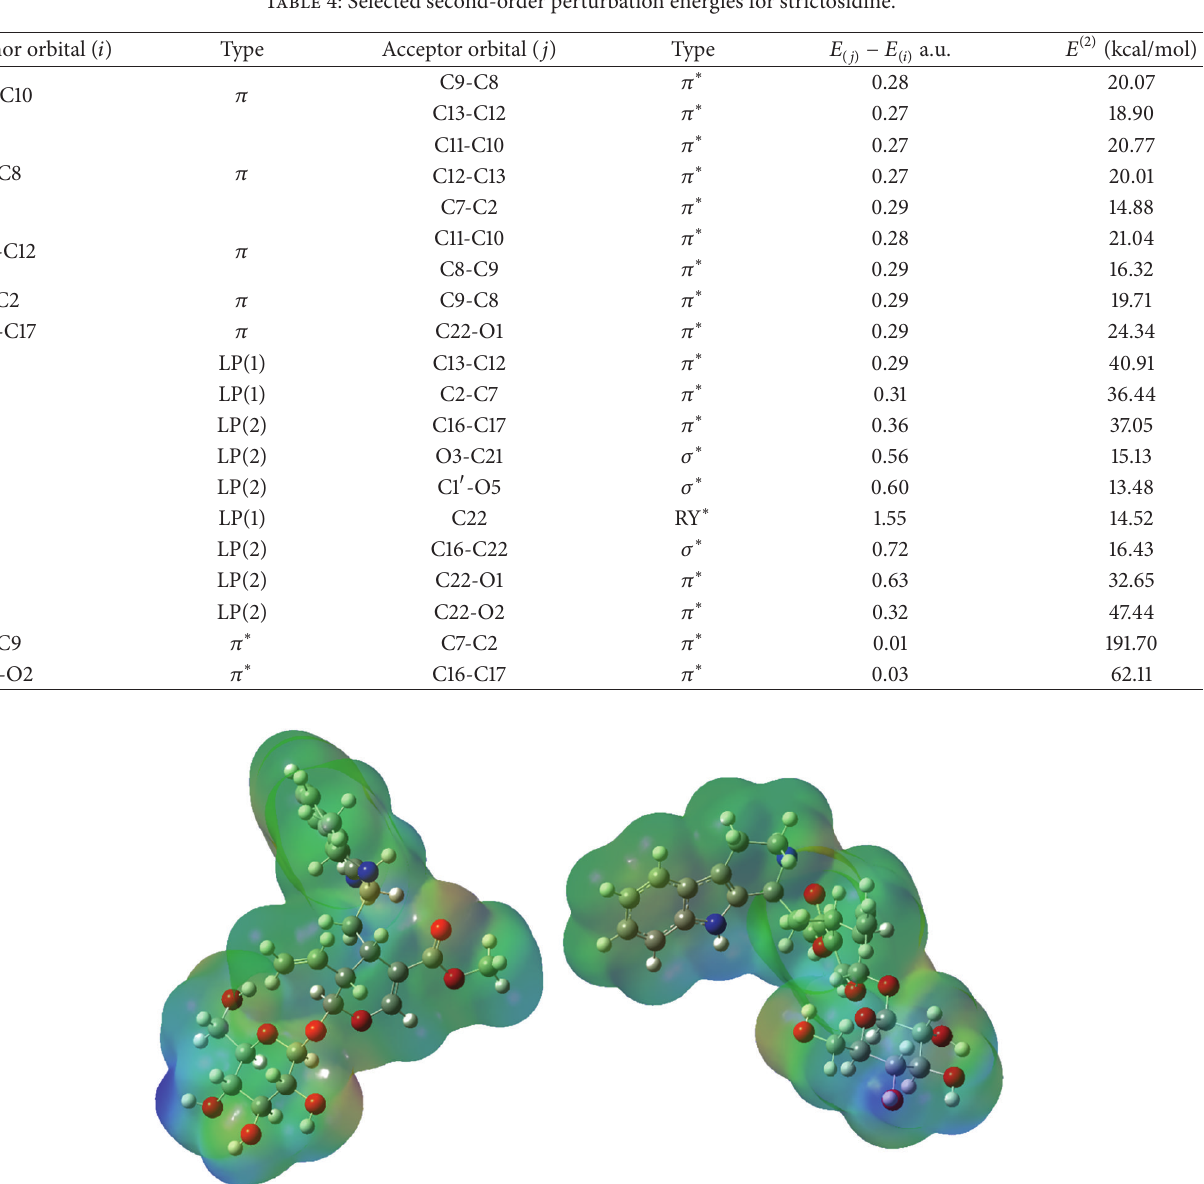
The MEPs for strictosidine indicated regions with positive potentials over H1 (0.0627 a.u.) and over the hydrogen atom of the OH group in position 4 󸀠 (0.0862 a.u.). Regions with negative potentials were located over the aromatic ring ( − 0.0429 a.u.), over the carbonyl group O2 ( − 0.0576 a.u.), between O4 and the OH group of C2 󸀠 position ( − 0.0643 a.u.), over OH on position C6 󸀠 ( − 0.0471 a.u.), and over oxygen atom on C4 󸀠 position ( − 0.0201 a.u.). The predominance of light green color region indicates great charge